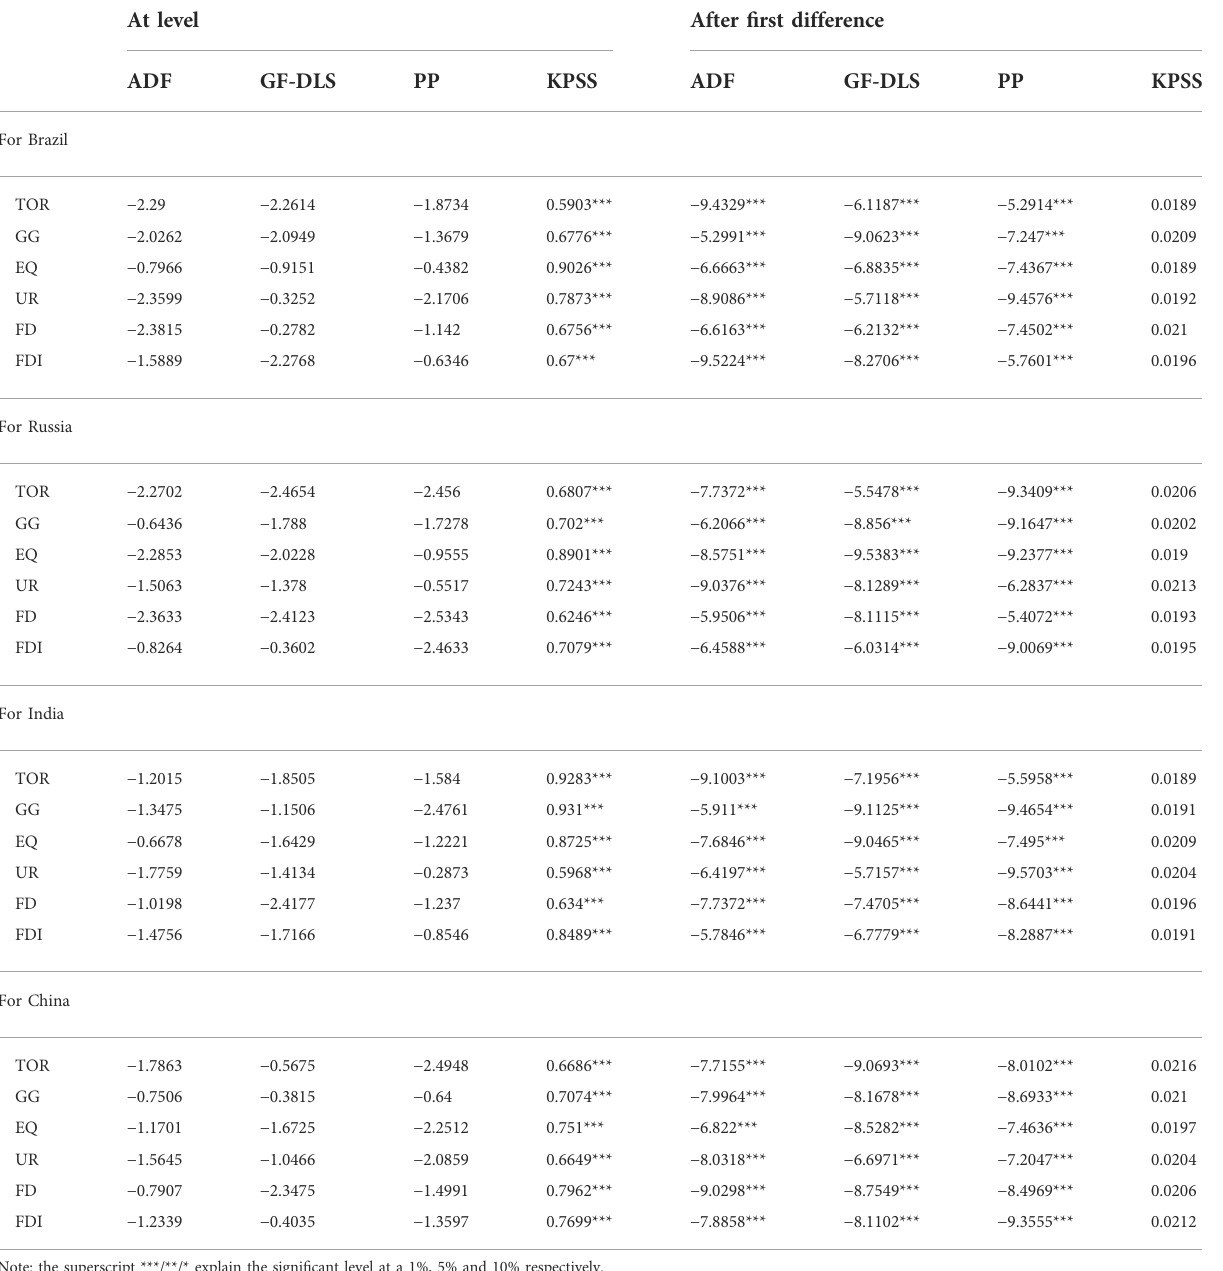
TABLE 3 Unit root